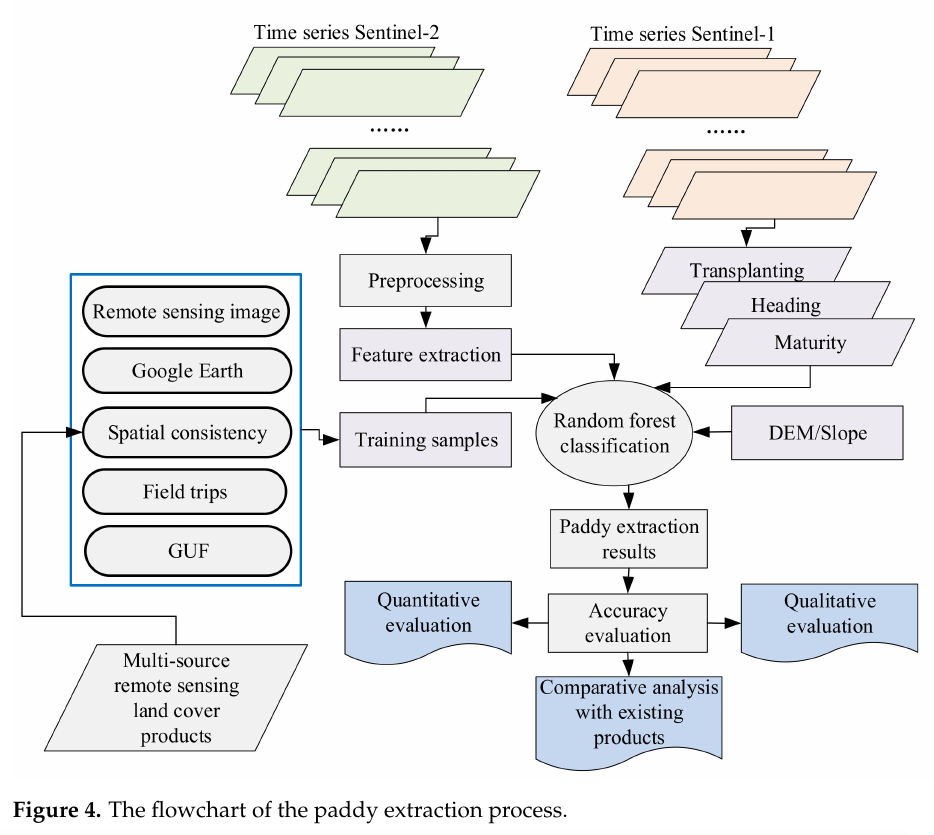
Figure 4. The flowchart of the paddy extraction process.